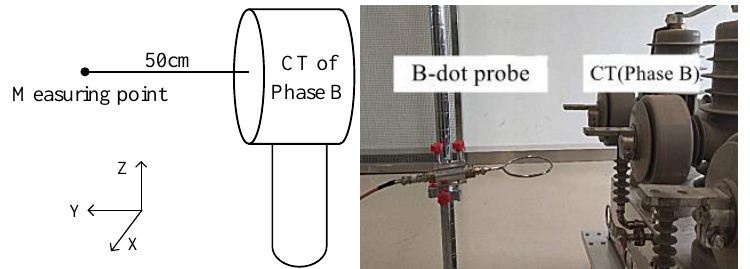
Figure 7. Schematic diagram of magnetic field measurement